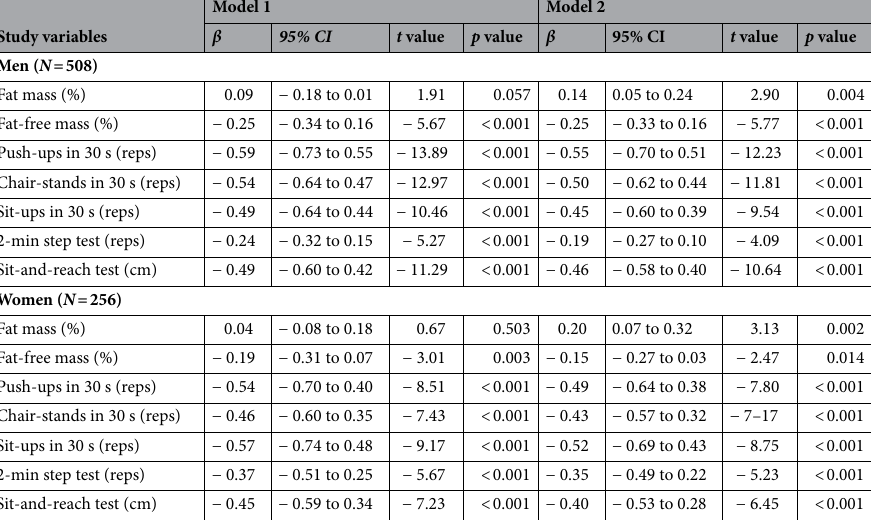
Table 2. The associations between health-related physical fitness and fasting blood glucose in the study participants, stratified by gender ( N = 764). Model 1: examines the associations between each health-related physical fitness test entered separately into the model and fasting blood glucose. Model 2: examines the associations between each health-related physical fitness test entered separately into the model and fasting blood glucose adjusted for age and body-mass